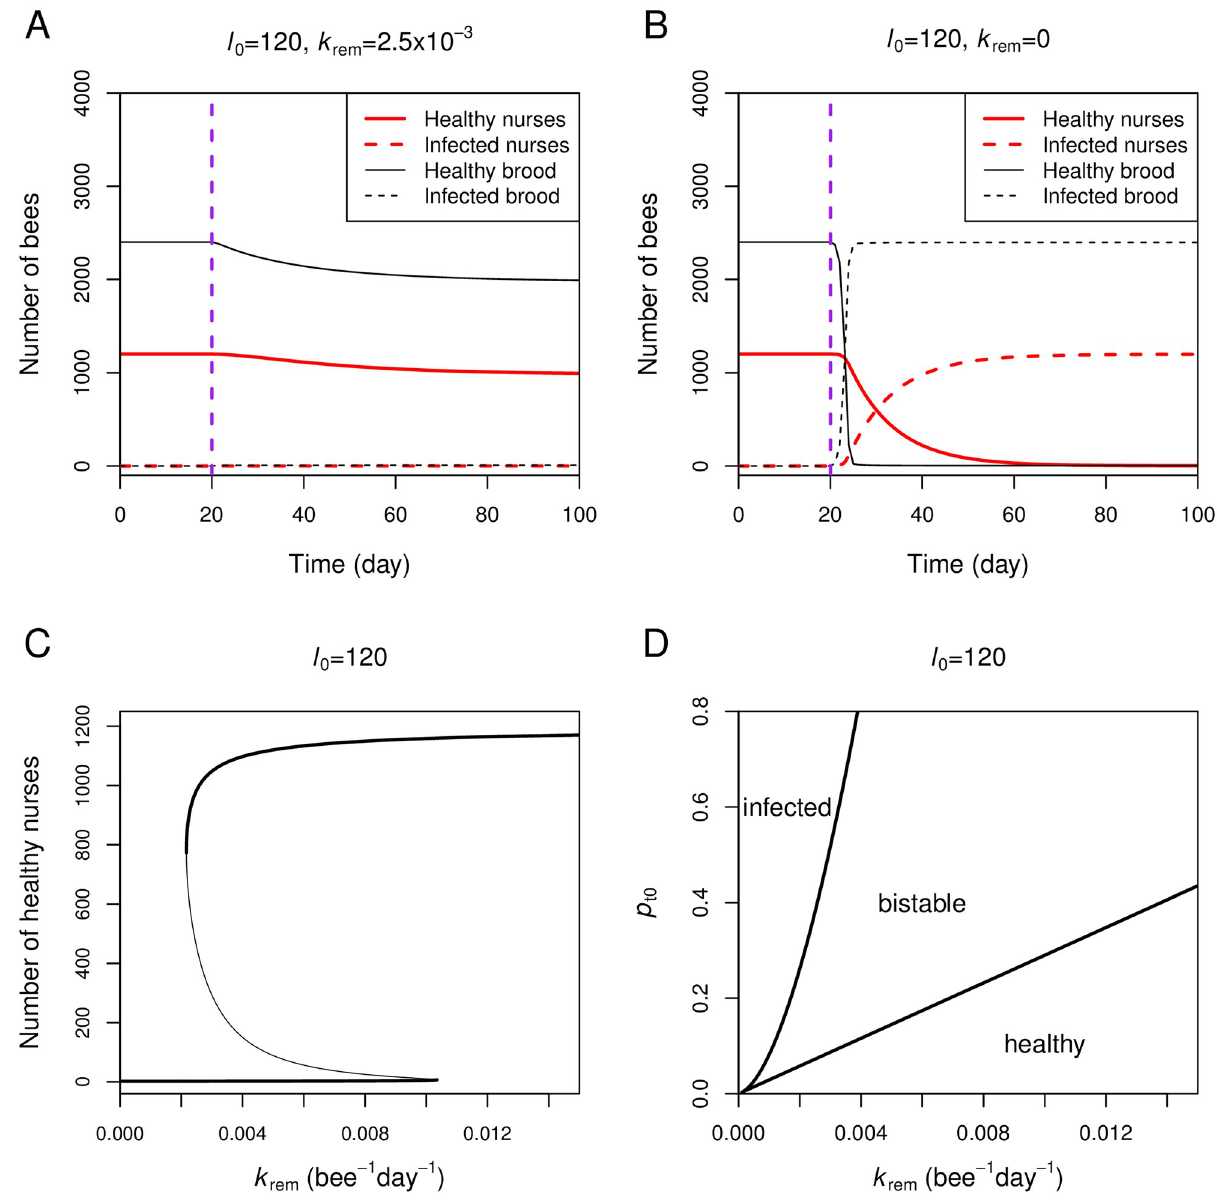
Fig 2. Role of the hygienic behavior ( k rem ). A: Healthy brood and nurses in a colony with the hygienic behavior are maintained against an infection. The simulation is based on Eqs 1–4 with model parameters listed in Table 1 with l 0 = 120 and k rem = 2.5 × 10 − 3 . We treat p t1 � k RN � iR 1 as a parameter, which is equal to 5 × 10 − 4 . The infection is introduced ( p t1 � k RN � iR 1 = 5 × 10 − 4 ) at day 20 (vertical purple line). B: All brood and nurses in a colony without the hygienic behavior become infected. The simulation setting is the same as in panel A, except that k rem = 0. C: The steady-state number of healthy nurses is plotted as k rem is varied while other parameters are fixed. Bold lines represent a stable steady-state and a thin line represents an unstable steady-state. D: The 2-parameter bifurcation diagram is plotted as both k rem and p t0 are varied. The diagram is divided into three regions depending on the state of the colony (healthy, bistable, and